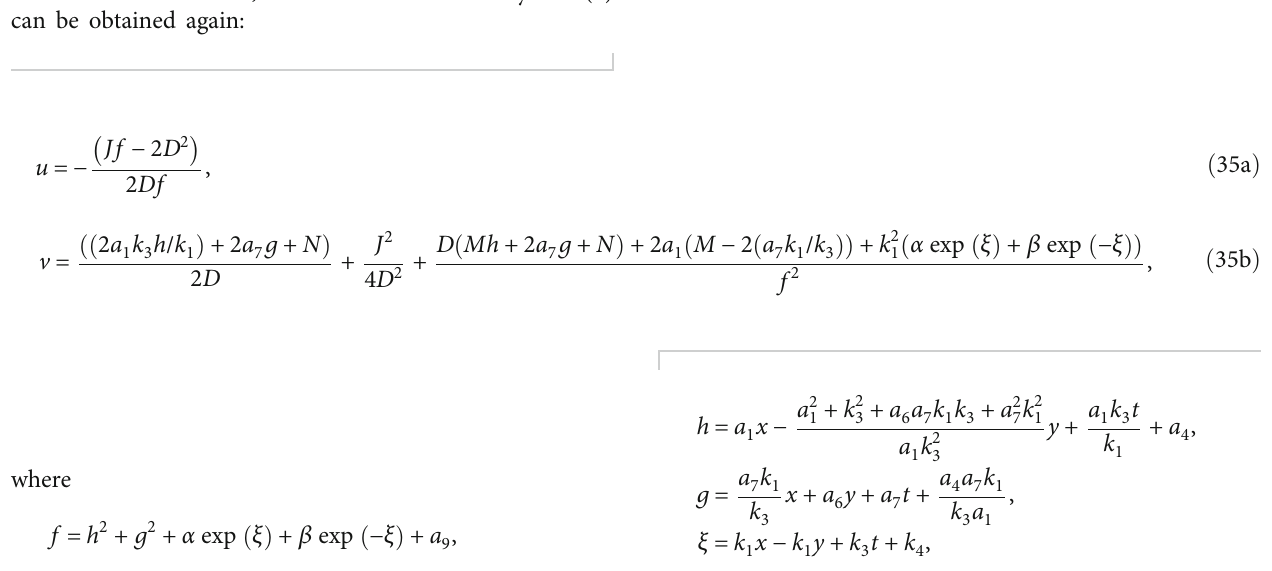
Figure 7: Pro fi les of the solution v via (17b) with a with the time t = 0 ; (b – d) the corresponding density plots with di ff erent